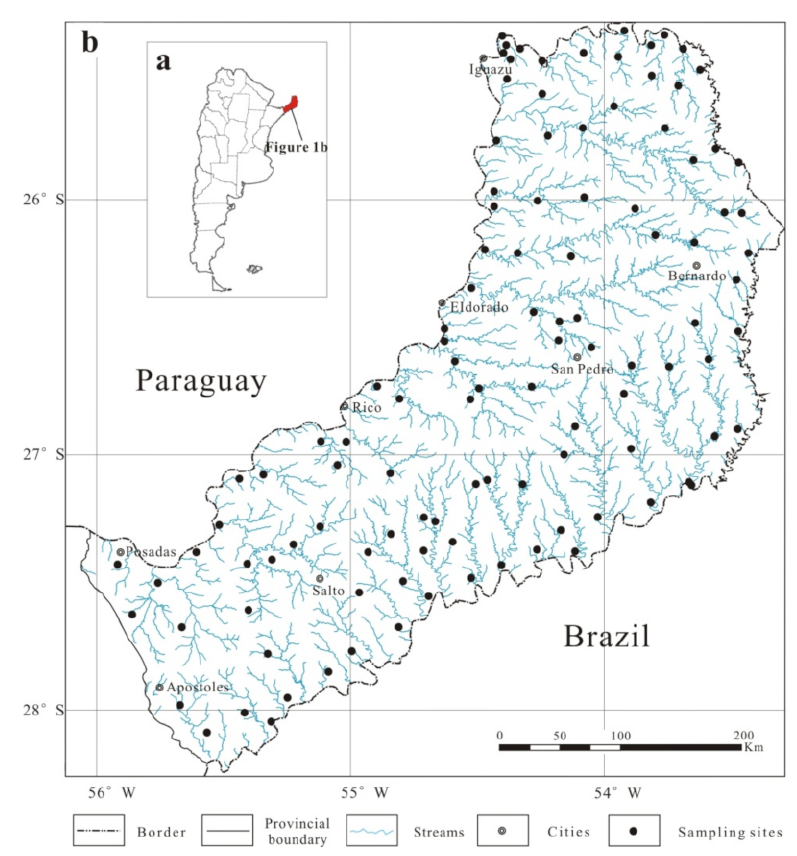
Figure 1. Sampling sites of stream sediments in the Misiones province, Argentina. ( a ): administrative map of Argentina; ( b ): the Misciones